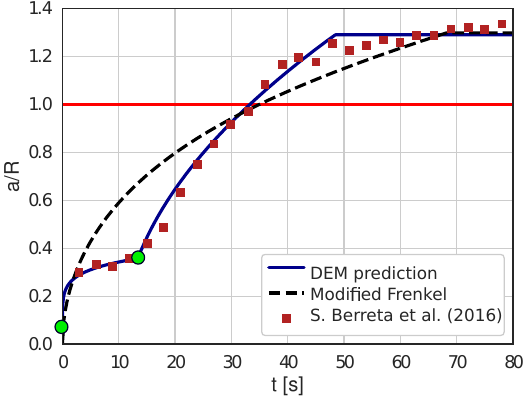
Figure 6. sintering curve of PEEK 450PF particles, R = 25 . 0 µ m compared with Frenkel’s model (dashed line), and experimental data (boxes)